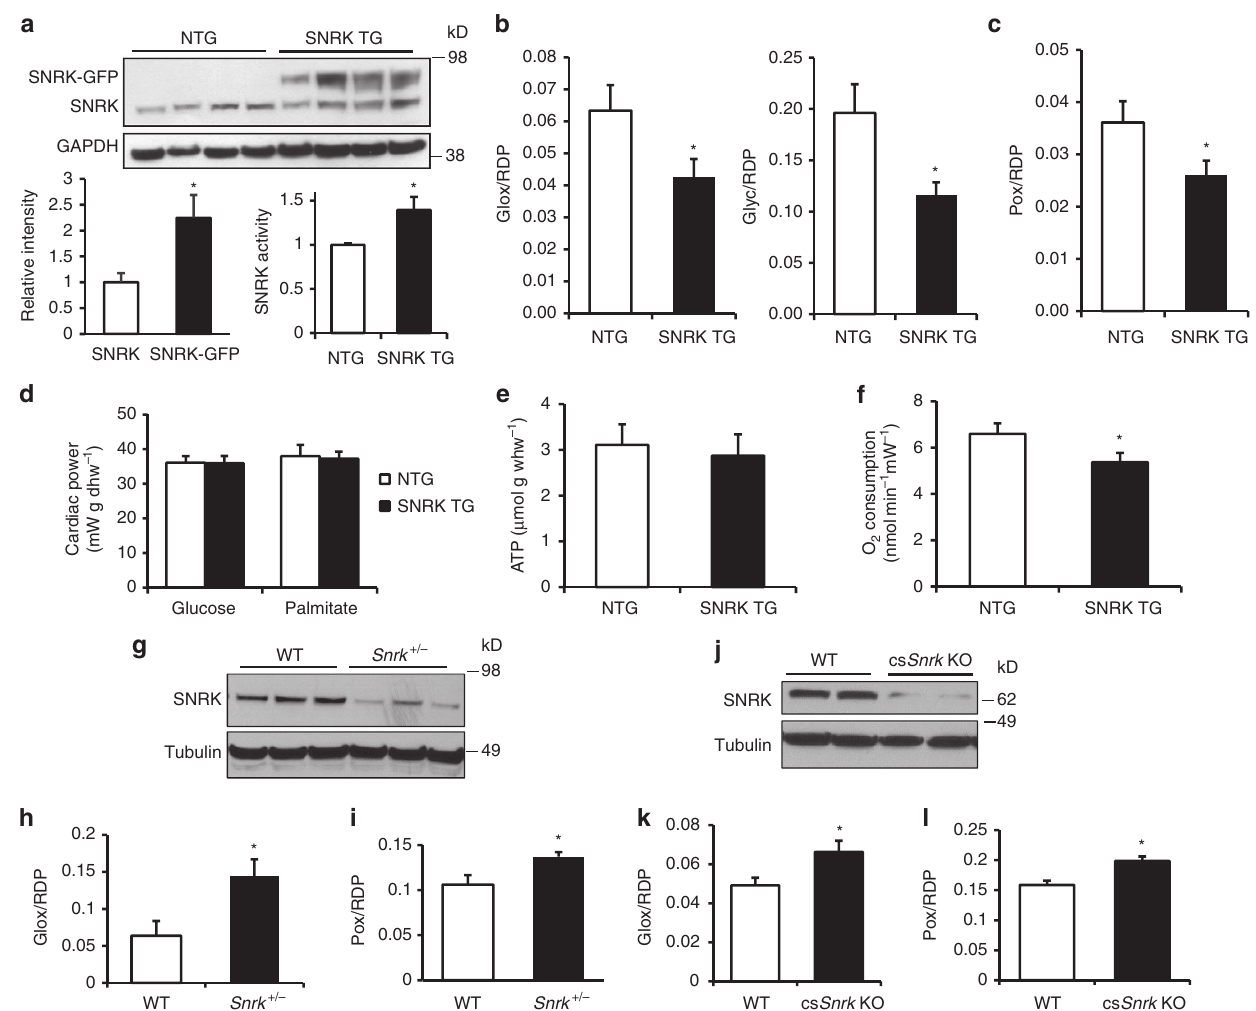
Figure 1 | SNRK decreases glucose and palmitate oxidation, but not cardiac function. ( a , top) Endogenous SNRK and SNRK-GFP transgene protein levels in NTG and SNRK TG mouse hearts using SNRK antibody. (bottom left) Quantification of endogenous SNRK and transgenic SNRK-GFP expression in the transgenic mice. (bottom right) Activity levels with H3.3 substrate peptide from whole-cell lysates of NTG and SNRK TG mouse hearts. Signal was normalized to background activity measured without addition of H3.3; n ¼ 3. ( b ) Glucose oxidation (Glox) and glycolysis (Glyc) normalized to rate-developed pressure product (RDP) in perfused working hearts from NTG and SNRK TG mice. n ¼ 6. ( c ) Palmitate oxidation (Pox) normalized to RDP in working hearts from NTG and SNRK TG mice. n ¼ 6. ( d ) Cardiac power measurements in NTG and SNRK TG hearts perfused with both glucose and palmitate, along with [5- 3 H]glucose and [U- 14 C]glucose (labelled glucose) or [9,10- 3 H]palmitate (labelled palmitate). ( e ) ATP levels in NTG and SNRK TG working hearts. n ¼ 6, whw ¼ wet heart weight. ( f ) Oxygen consumption in NTG and SNRK TG working hearts normalized to cardiac power. n ¼ 6. ( g ) SNRK protein levels in WTand Snrk þ / (cid:2) hearts, representative of 4–5 independent samples. ( h ) Glox normalized to RDP in perfused working hearts from WT and Snrk þ / (cid:2) mice. n ¼ 5 for WT, n ¼ 4 for SNRK þ / (cid:2) . ( i ) Pox normalized to RDP in working hearts from WT and Snrk þ / (cid:2) mice. ( j ) SNRK protein levels in WTand cs Snrk KO mice, representative of three independent samples. ( k ) Glox normalized to RDP in perfused working hearts from WT and cs Snrk KO mice. n ¼ 9 for WT, n ¼ 10 for cs Snrk KO. ( l ) Pox normalized to RDP in perfused working hearts from WT and cs Snrk KO mice. Data are represented as mean ± s.e.m. * P r 0.05 by Student’s t